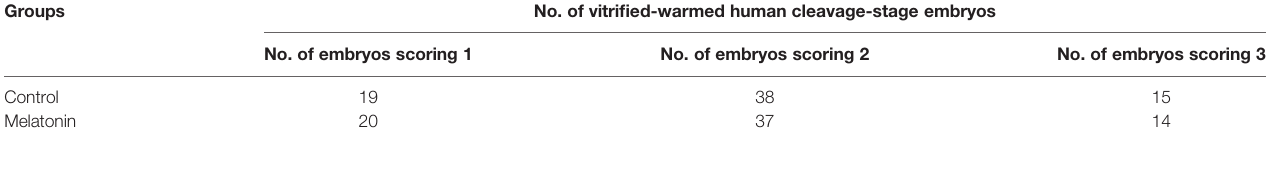
TABLE 3 | Primers used in this